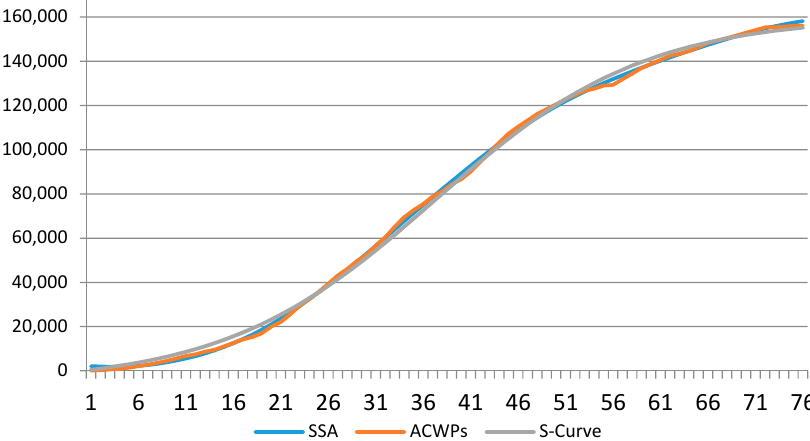
Figure 11. Reconstructed trend from the eigentriples 1 to 9 compared with ACWP and S-Curve